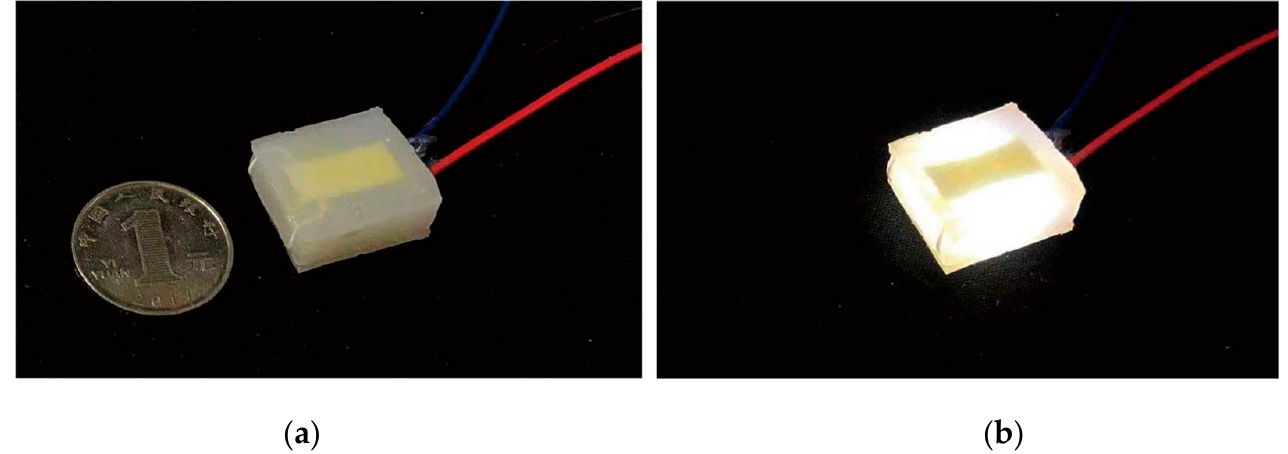
Figure 4. The manufactured sensing unit. ( a ) unit without power ( b ) unit with power.